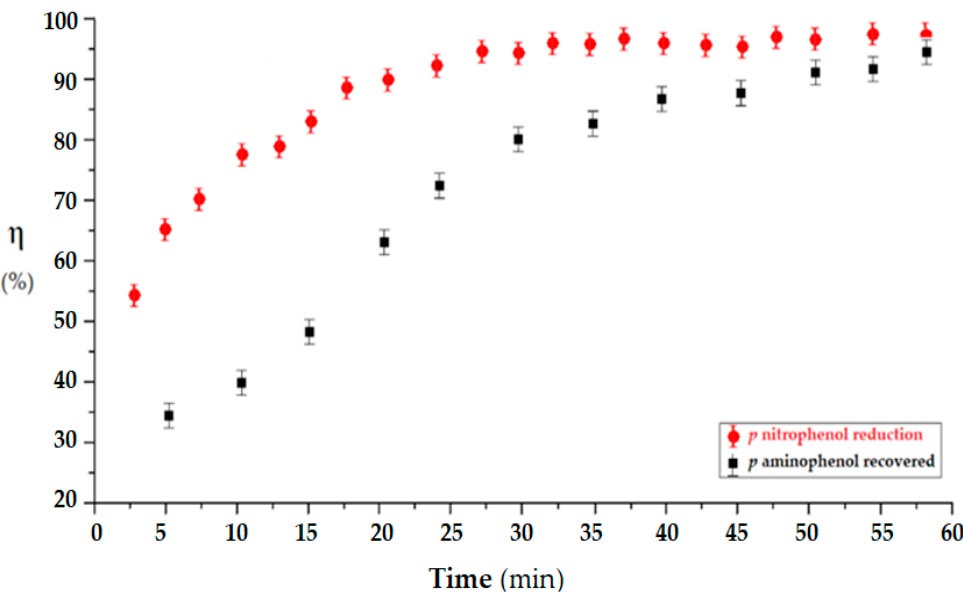
Figure 13. The evolution of the transformation efficiency of p -nitrophenol to p -aminophenol (in red) and of the recovery efficiency of p -aminophenol (in black).